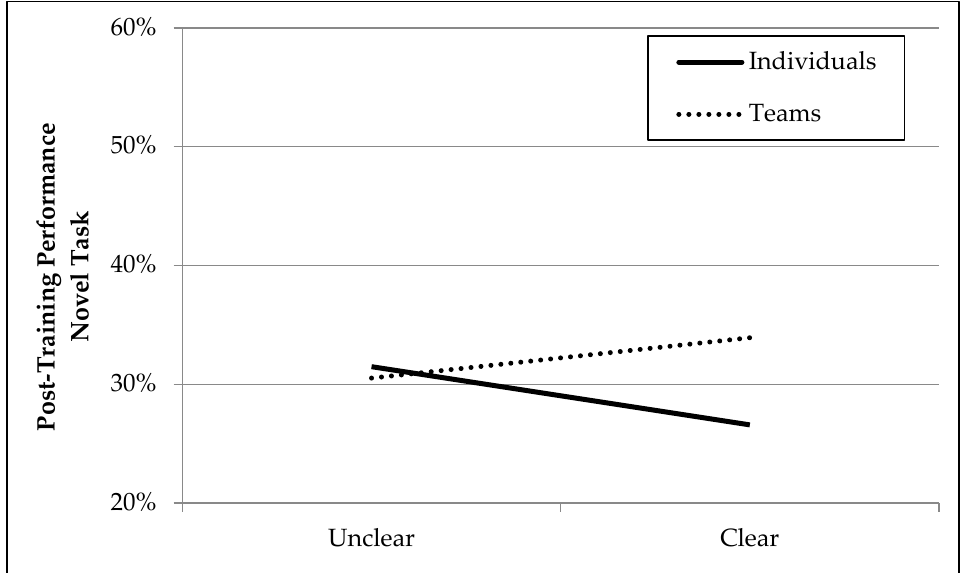
Figure 2. Human interaction moderating the relationship between rules/goals clarity and post ‐ training performance in a novel task.